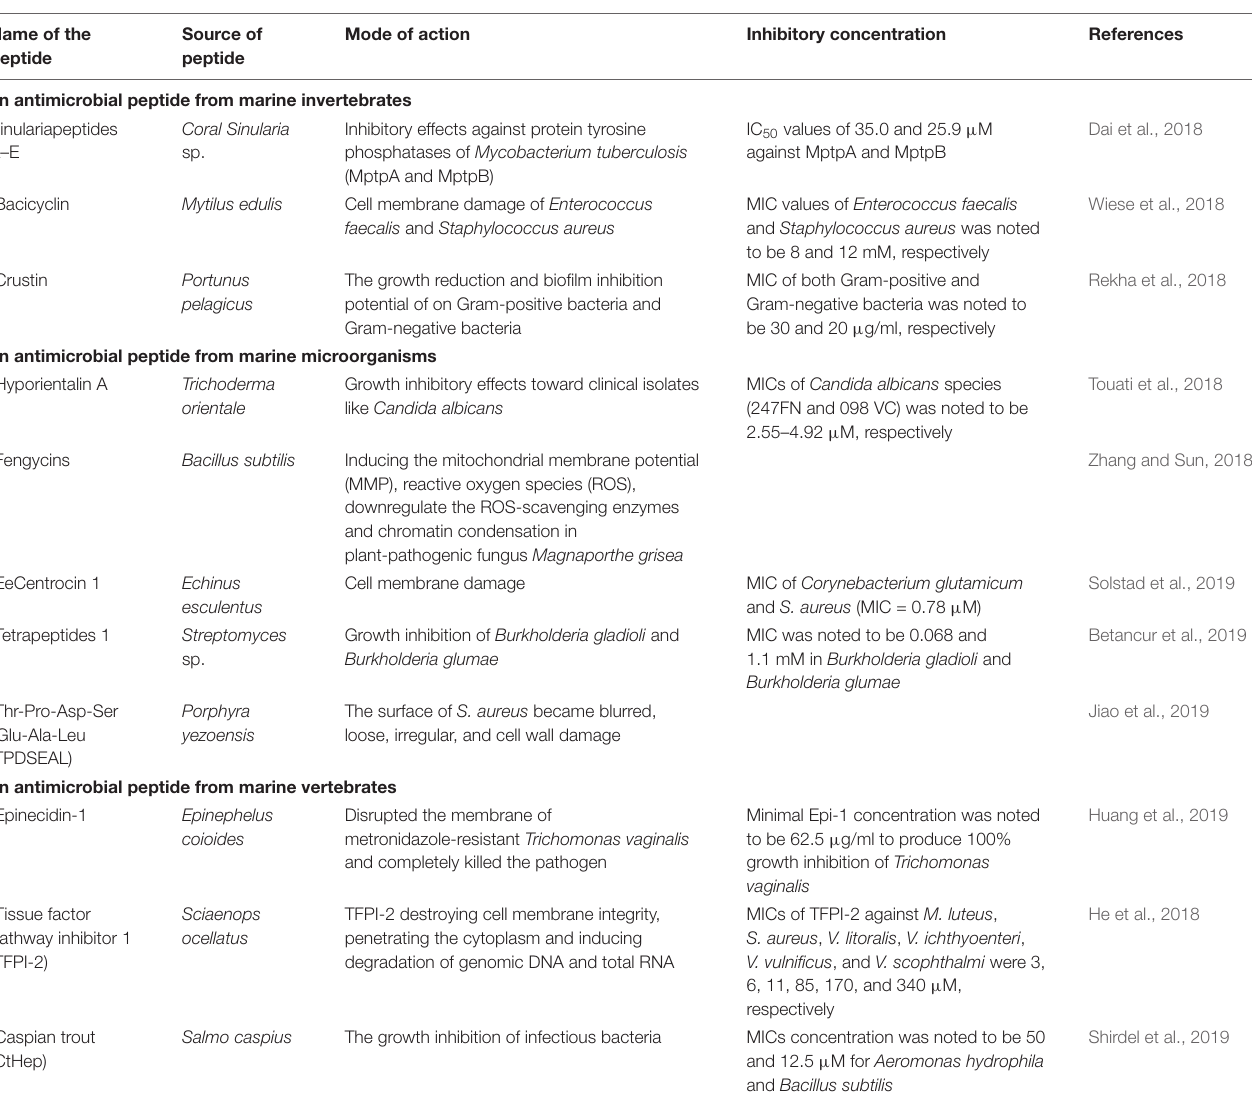
TABLE 3 | Antimicrobial peptides from marine